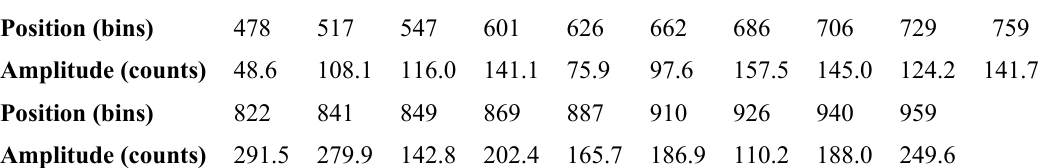
Table 1. Positions and amplitudes of layers on the measured, 842 nm integrated LiDAR data from small conifer. The background level was estimated at 854.2 counts and the mean rms fitting error was 0.67